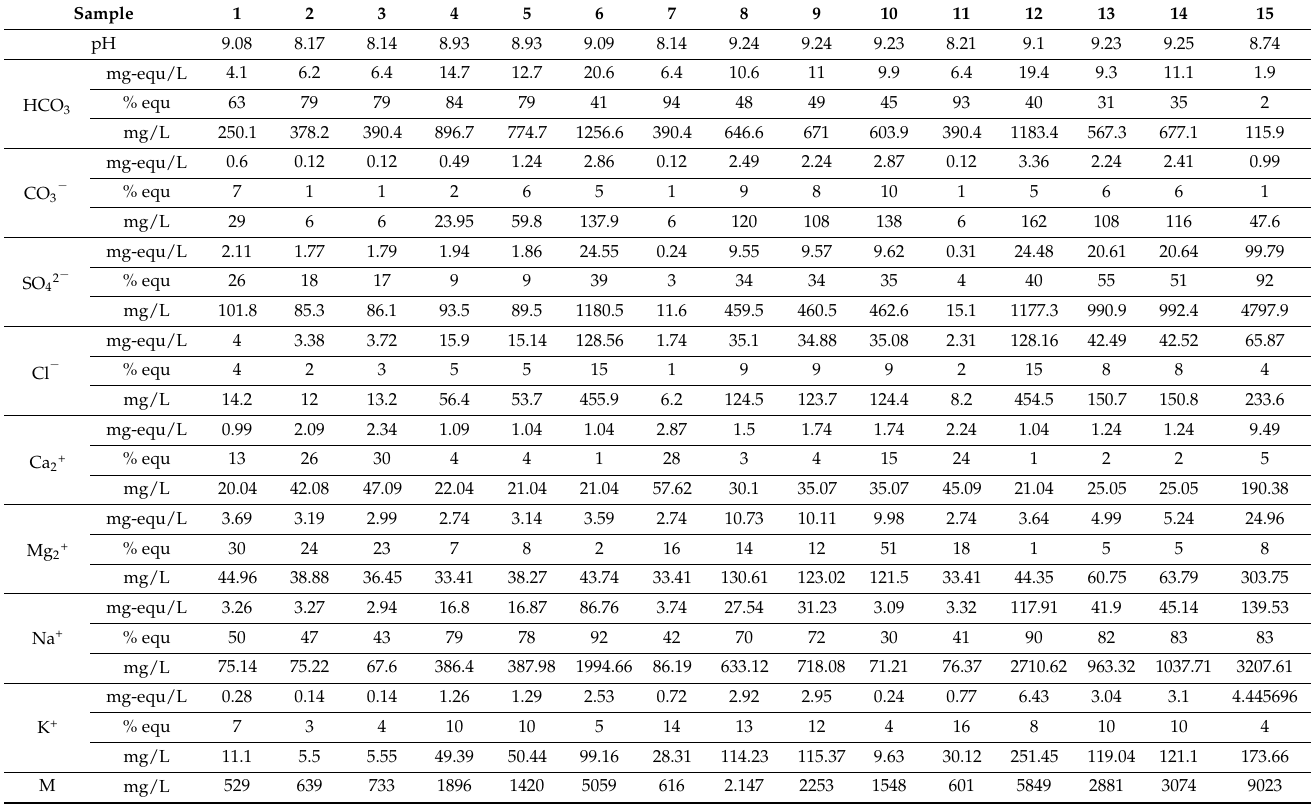
Table 3. Content of macrocomponents and mineralization (M) of lakes within Burabay rock